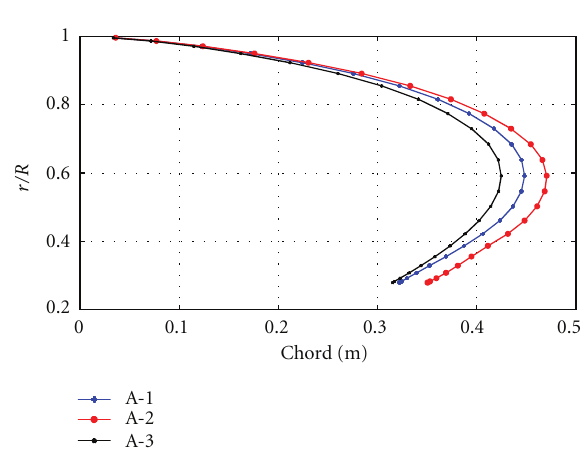
Figure 14: Chord lengths, aft propeller.